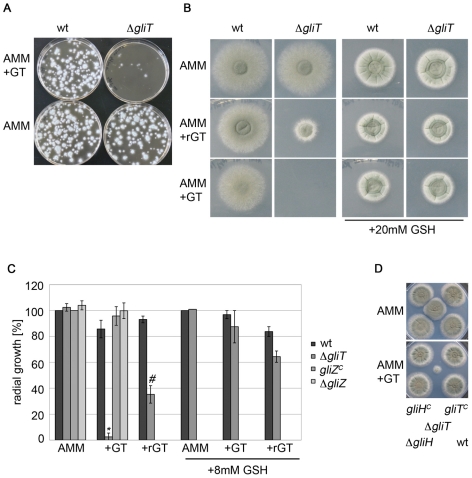
Exogenous gliotoxin specifically inhibits growth of A. fumigatus ΔgliT.(A) Protoplasts of A. fumigatus wild-type (ATCC46645) and ΔgliT were poured onto AMM plates, in the presence or absence of gliotoxin (10 µg/ml). Plates were incubated for 48 h at 37°C. (B) Conidia (A. fumigatus ATCC26933 and ΔgliT; 104/spot) were dotted on AMM plates containing the indicated supplement and incubated for 48 h at 37°C. To obtain reduced gliotoxin (rGT) free of additional thiols, 10 µg/ml GT was reduced with 50 mM NaBH4 for 60 min at room temperature. Gliotoxin (GT) and rGT were added at a final concentration of 10 µg/ml. (C) Quantification of radial growth of A. fumigatus ATCC26933, ΔgliT, ΔgliZ and complemented ΔgliZ (gliZ
c) [14] in the presence of gliotoxin and rGT, with and without exogenous GSH. Strains (104 conidia) were dotted on AMM containing GT (gliotoxin; 10 µg/ml), rGT (10 µg/ml), or reduced glutathione (8 mM), respectively. Colony diameter was measured after 48 h of incubation at 37°C and experiments were repeated in triplicate. * indicates a significance level of p<0.0001 and # indicates p<0.05. Note: For clarity, A. fumigatus ΔgliZ and gliZ
c (gliZ complemented) data are only shown for AMM +/− GT only, as their growth was unaffected by all conditions tested. (D) A. fumigatus ΔgliH is unaffected by gliotoxin presence. 104 conidia were spotted on AMM with GT (10 µg/ml, bottom) or without GT (top). Plates were incubated for 72 h (hence the visible background growth of ΔgliT). A. fumigatus ΔgliH did not show any sign of an altered growth phenotype in the presence of gliotoxin.